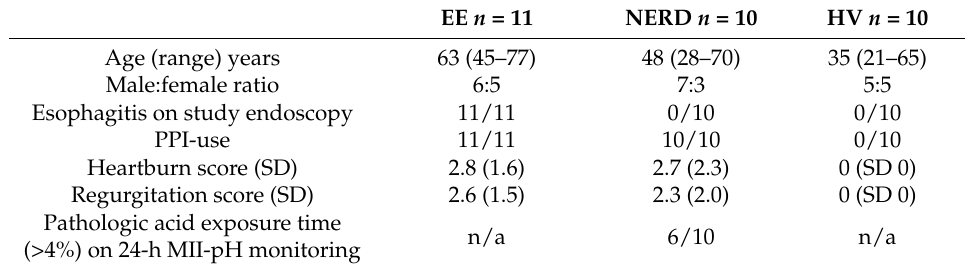
Table 1. Group characteristics.